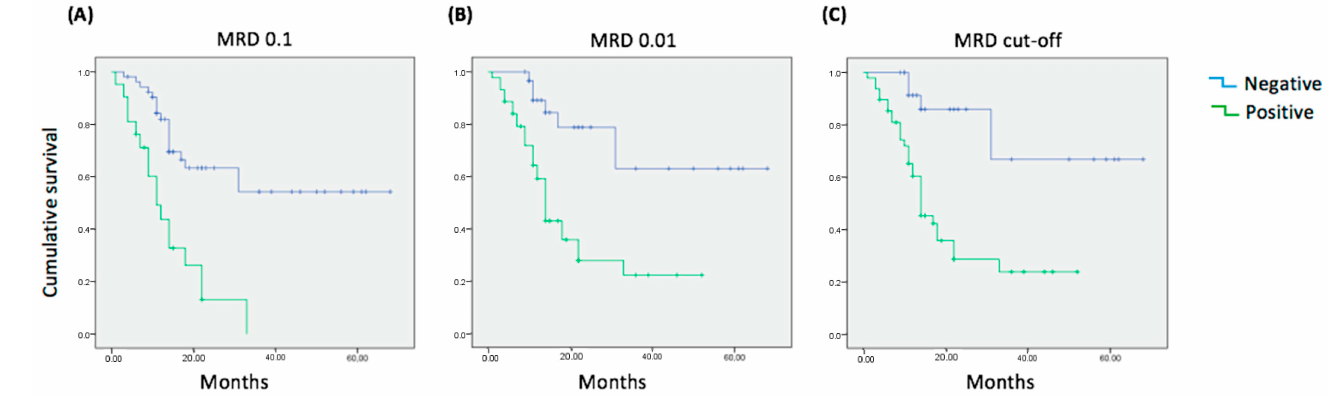
Figure 6. Kaplan–Meier survival curves for AML patients using 3 different cut-offs for the evaluation of MRD in remission samples after first induction cycle. ( A ) Time to relapse in AML patients using an MRD threshold of 0.1. (PFS = 39.18 ± 3.3 months; p = 0.001). ( B ) Time to relapse in AML patients using an MRD threshold of 0.01. (PFS = 50.5 ± 4.3 months; p < 0.001). ( C ) Time to relapse in AML patients using individual MRD threshold (PFS = 53.7 ± 4.6 months; p < 0.001).